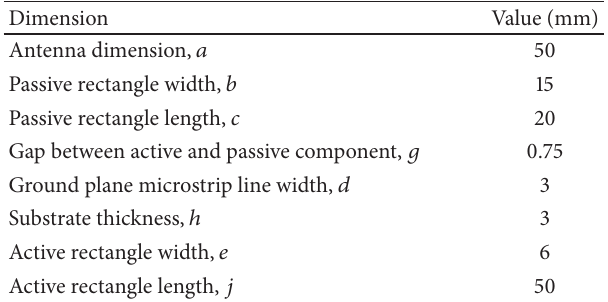
Table 2: Design parameters of the proposed